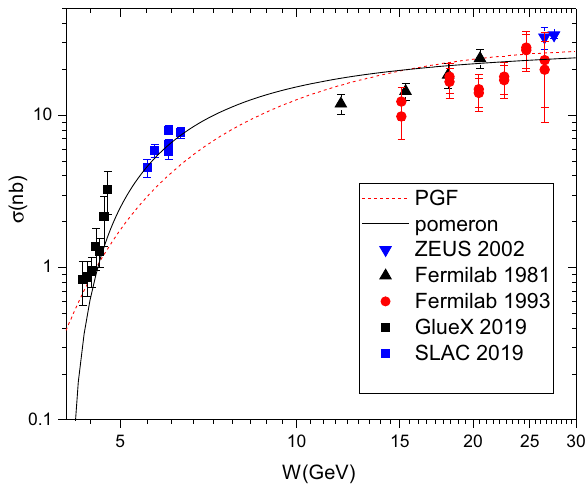
Fig. 3 The total cross section of γ p → J /Ψ